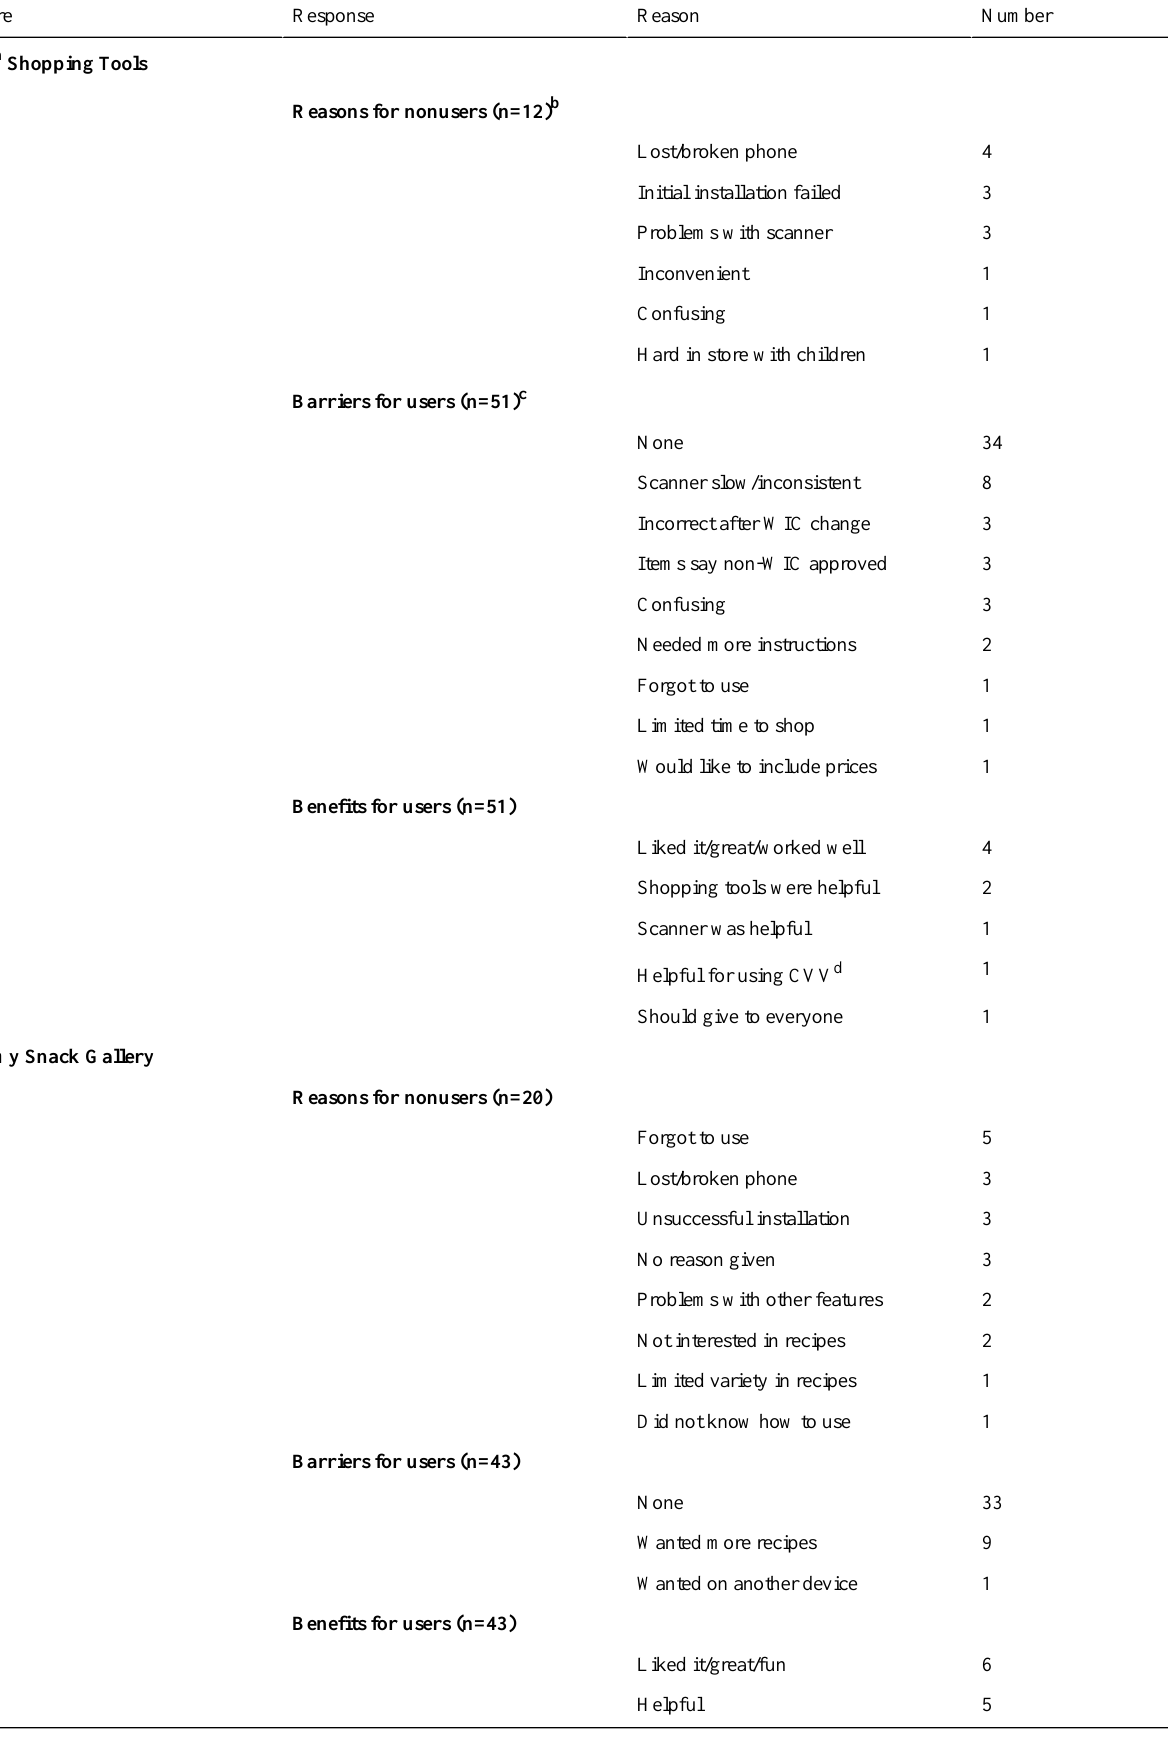
Table 3. Summary of qualitative feedback from users on Children Eating Well smartphone app prototype